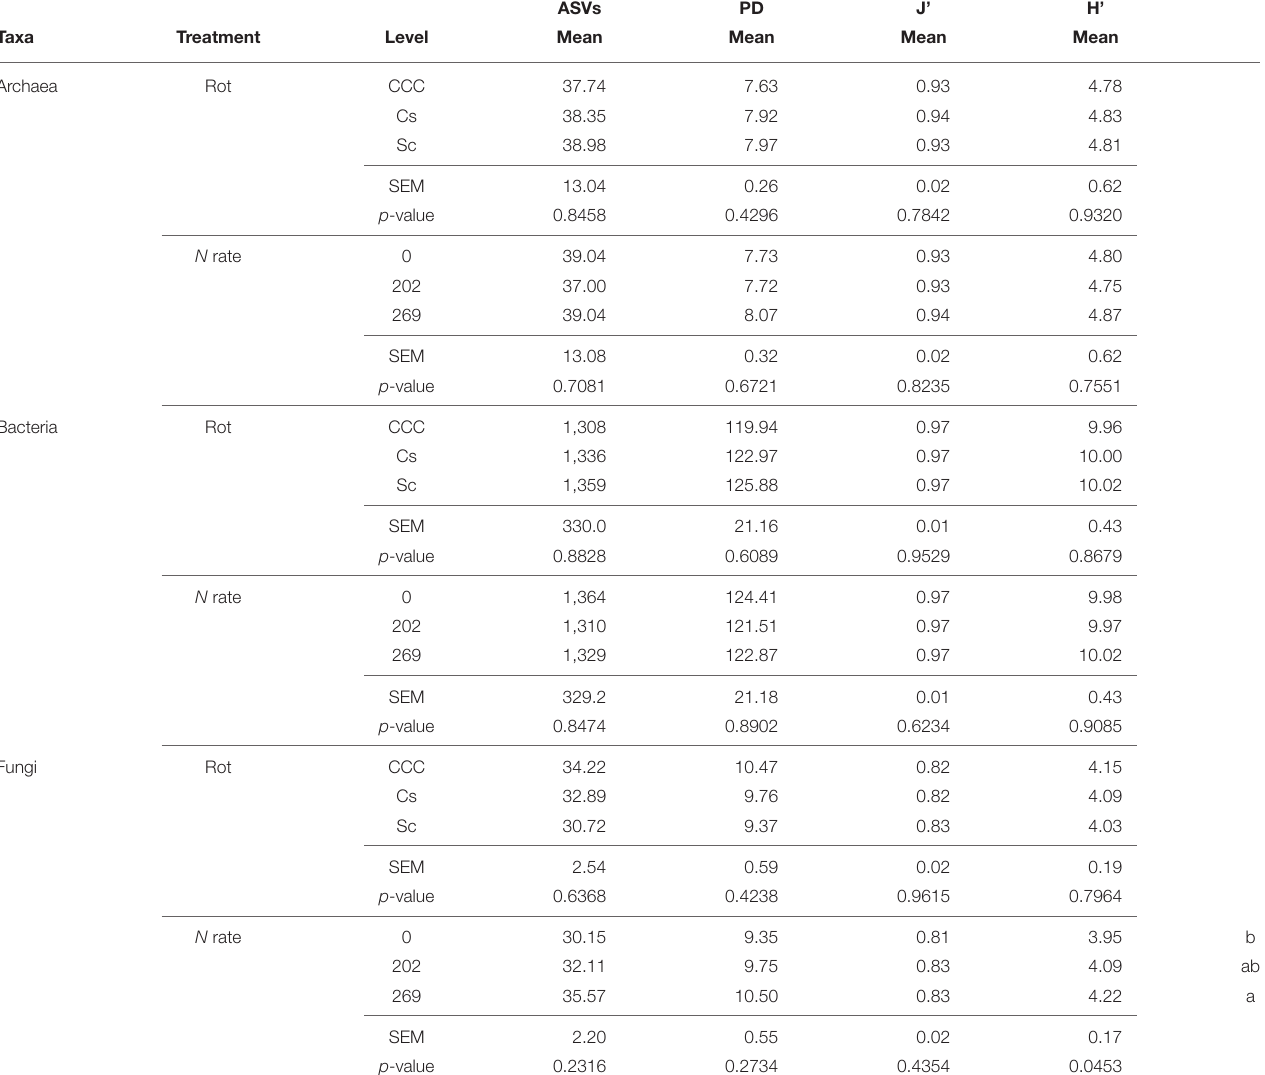
TABLE 1 | Mean values, standard error of the mean (SEM), and probability values ( p -values) associated with the ANOVA for the α -diversity parameters amplicon sequence variants (ASVs), Faith’ phylogenetic diversity index (PD), Pielou Evenness Index (J’), and Shannon’s Diversity Index (H’) for bacteria, fungi, and archaea taxa, following 35 years of Rotation (Rot) and N fertilization ( N rate) †